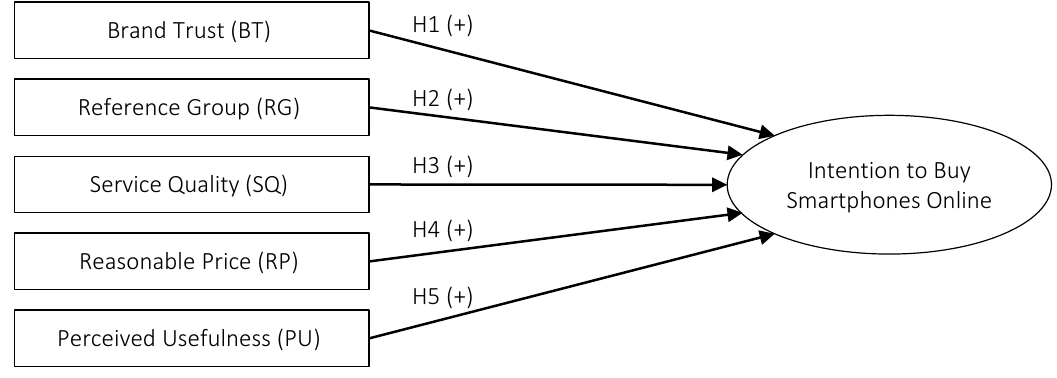
Figure 1. Research model